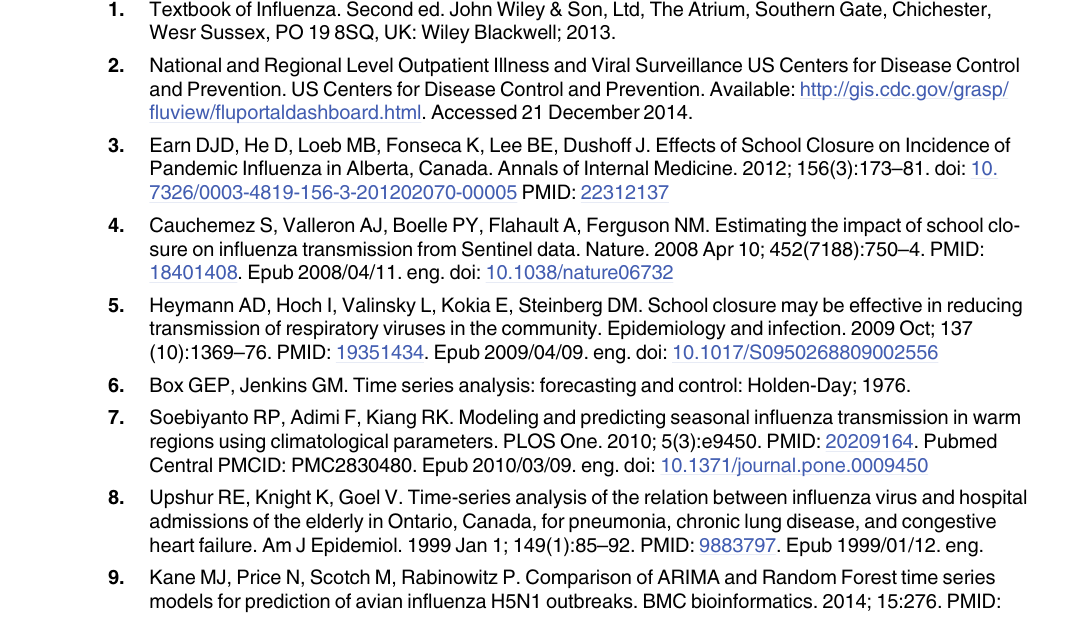
S1 Table. Bayesian information for the candidate ARIMA models to forecast the 2004 week-52 ILI rate. S2 Table. ARIMA models and predictions for week 44 to week 8 from influenza season 2004 – 2005 to 2012 –